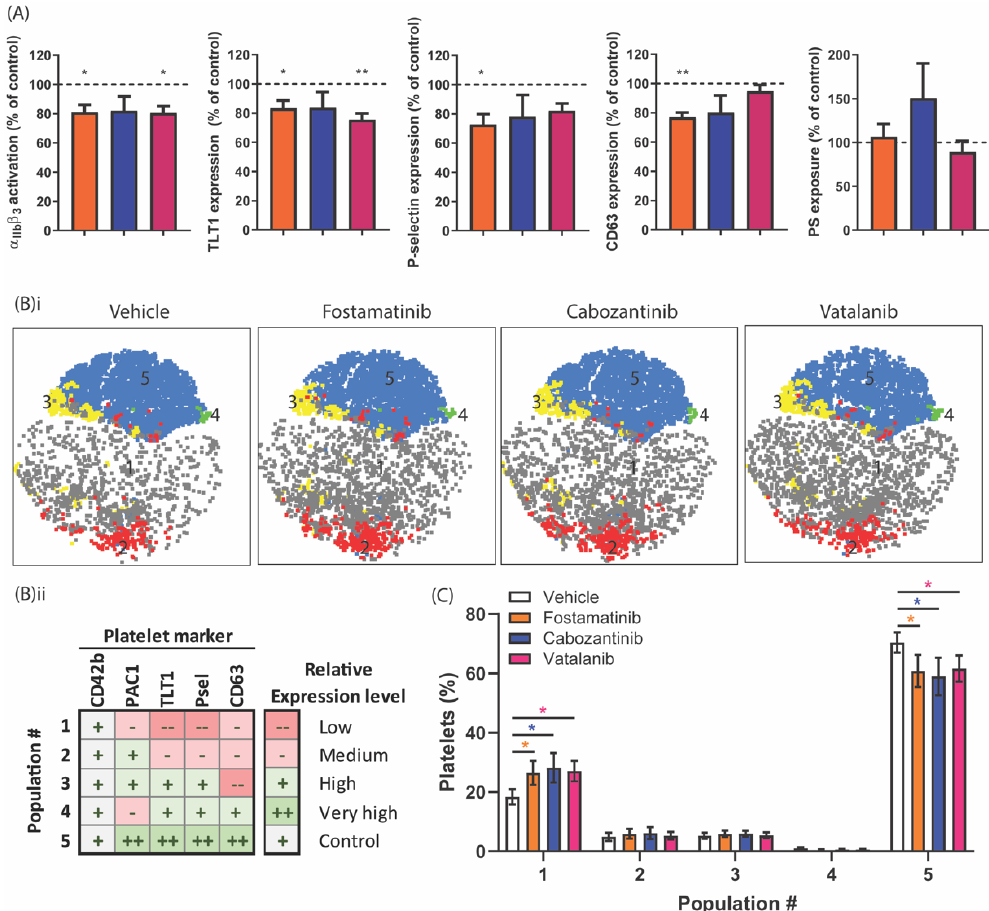
Figure 5. Effect of TKIs on populations of activated platelets in response to GPVI stimulation. Washed platelets (25 × 10 9 /L) were incubated with vehicle, fostamatinib (33 µM), cabozantinib (33 µM), or vatalanib (33 µM) for 10 min. Platelet activation was induced by 5 µ g/mL of CRP-XL for 15 min and simultaneously labeled for activated integrin α IIb β 3 (PAC1-FITC), α -granule secretion ( α TLT1-BV421 and α CD62P-PerCP Cy5.5) and δ -granule/lysosome secretion ( α CD63-APC). Separately, PS exposure was induced using 5 µg/mL of CRP-XL, in addition to 4 nM of thrombin for 60 min at 37 °C, labeled by annexin A5-PE. ( A ) Histograms of integrin α IIb β 3 activation, TLT1, P-selectin, and CD63 expression, as well as PS exposure, are shown as percentages of the control condition. ( B ) Distribution profiles of the platelet populations after stimulation by CRP-XL. ( i ) Two-dimensional plots visualizing the platelet fractions per population in the presence of vehicle, fostamatinib, cabozantinib, or vatalanib. ( ii ) Characterization of CRP-XL-induced platelet populations based on the relative expression levels of activation markers determined by FlowJo analysis using the tSNE and FlowSOM plugins (see Table S2). ( C ) Histograms visualizing the abundance of a certain platelet population (FlowSOM) found in a particular platelet fraction (conditions: vehicle (white bars) or fostamatinib, cabozantinib, or vatalanib (colored bars)). The sum of all the population abundance percentages of a fraction (e.g., the vehicle) amounts to 100% platelets. Data are shown as means ± SEM ( n = 6); * p < 0.05 and ** p < 0.01.